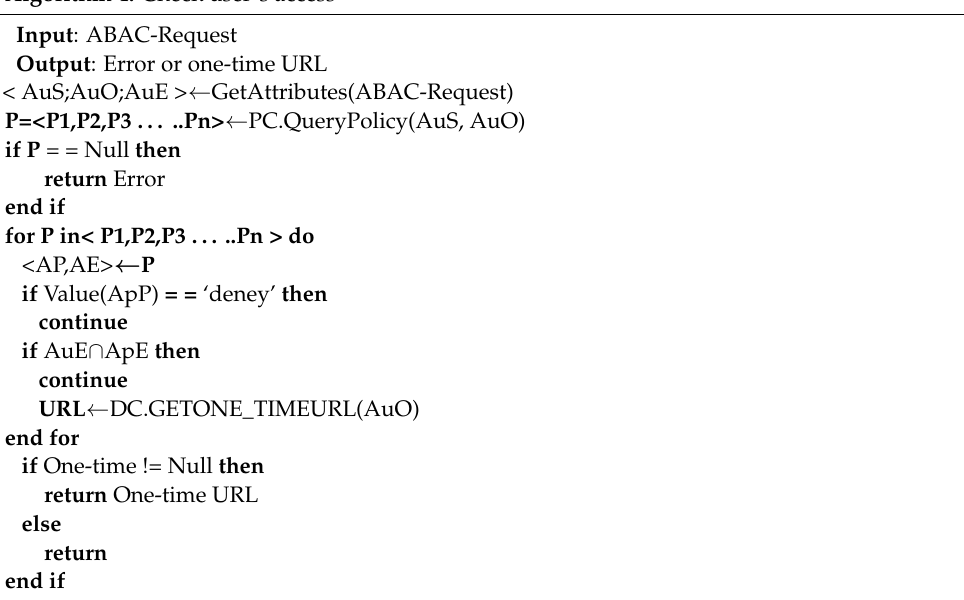
Algorithm 4: Check user’s